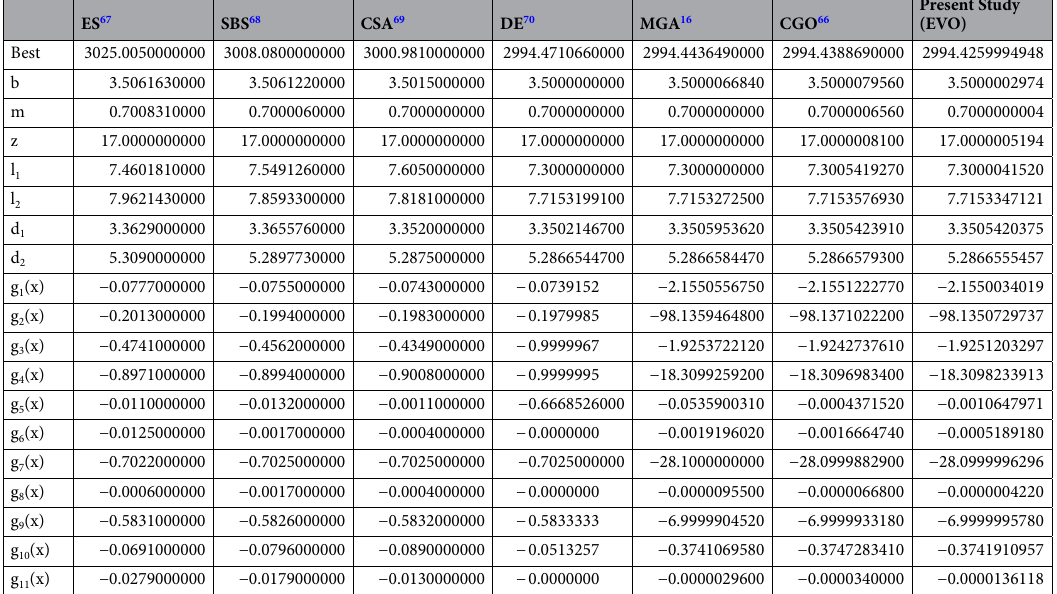
Table 8. Best results of different approaches for the speed reducer problem. teeth module (m), face width (b), length of the first shaft between bearings (l1), the diameter of the first shaft (d1), number of teeth on pinion (z), length of the second shaft between bearings (l2), the diameter of the second shaft (d2). ES, Evolution strategy; SBS, Socio-behavioural simulation; CSA, Cuckoo search algorithm; DE, Differential